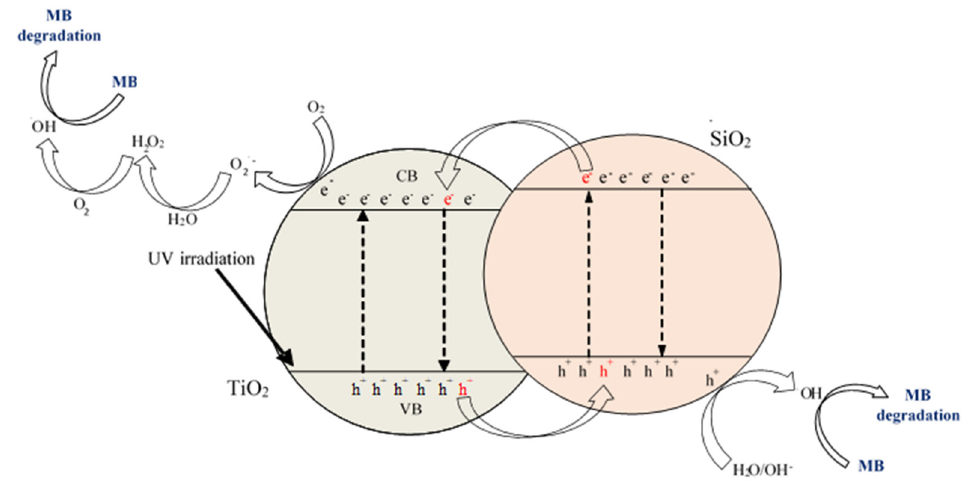
Figure 11. Schematic of the photocatalysis mechanism on SiO 2 /TiO 2 surface (based on [57]).